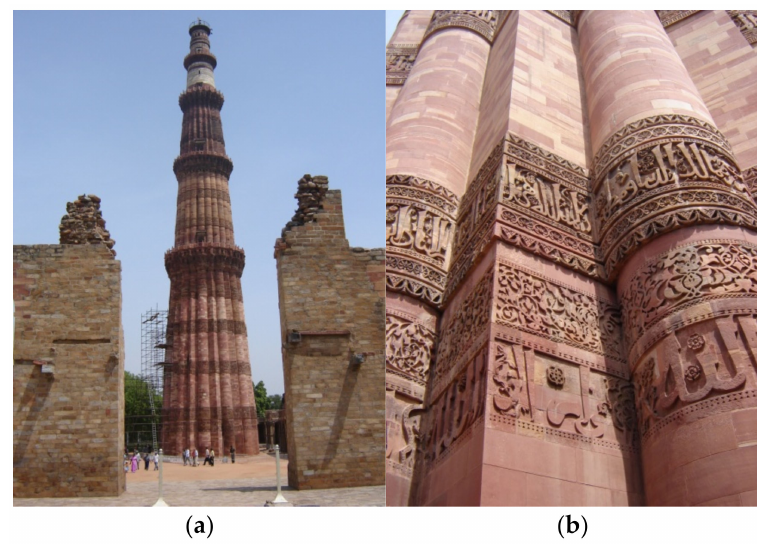
Figure 9. Qutb Minar tower: ( a ) exterior view and ( b ) detail of the fluted